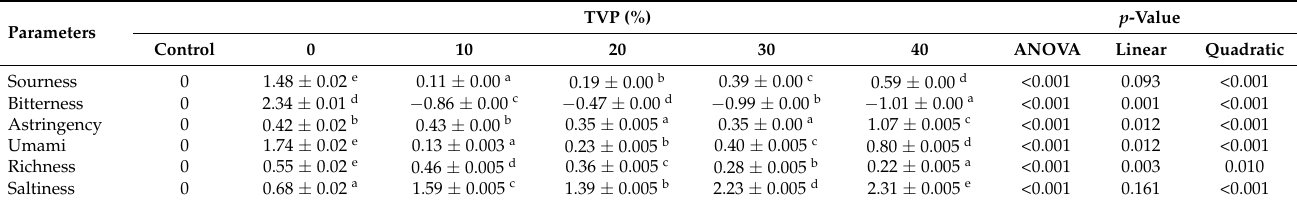
Table 5. Sensory evaluation of beef patties made with different levels of TVP by an electronic tongue system.